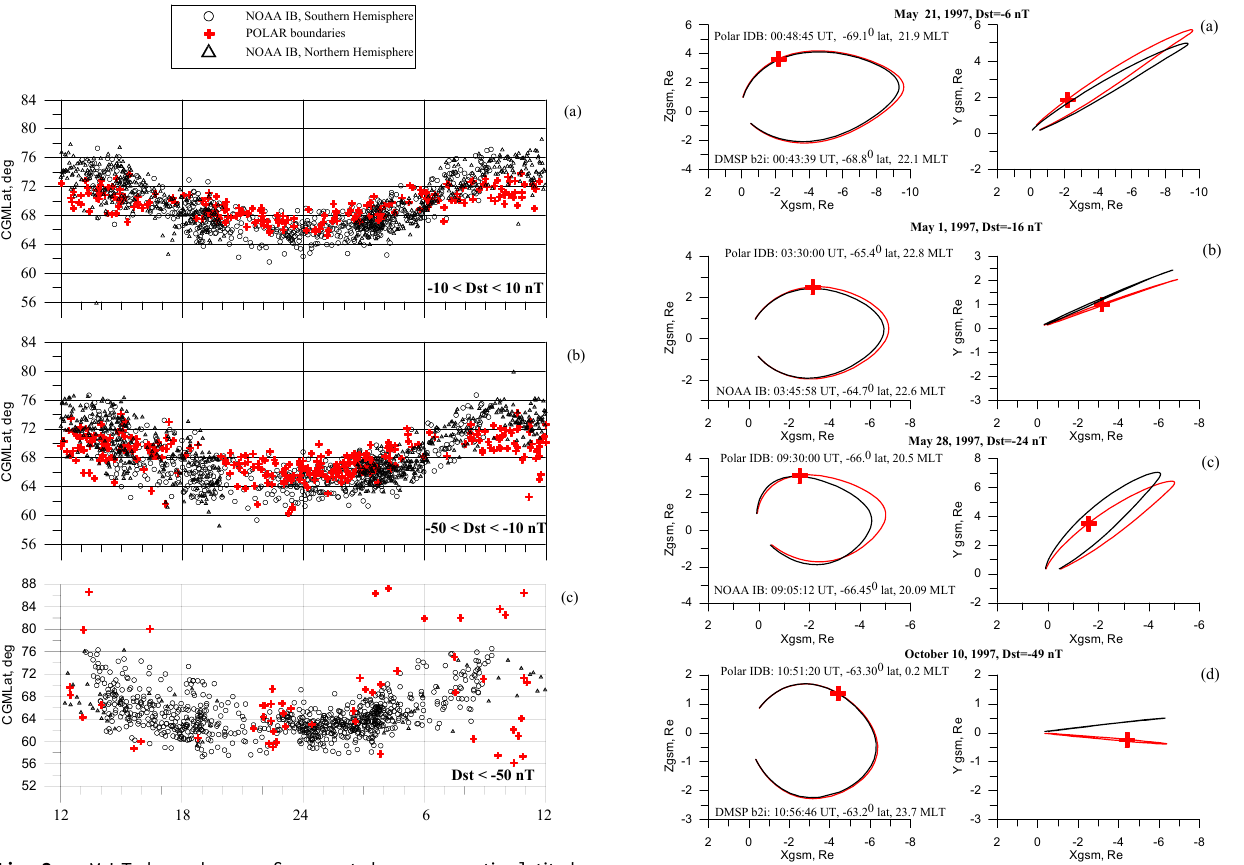
Fig. 3. MLT-dependence of corrected geomagnetic latitudes of isotropic distribution boundaries (IDB) observed by Polar CAMMICE/MICS (red crosses), together with isotropic bound- aries (IB) observed by NOAA 12 satellites in the North- ern (open triangles) and Southern (open circles) Hemispheres for ( a ) − 10nT <D st < 10nT, ( b ) − 50nT <D st < − 10nT, and ( c ) D st < − 50nT.